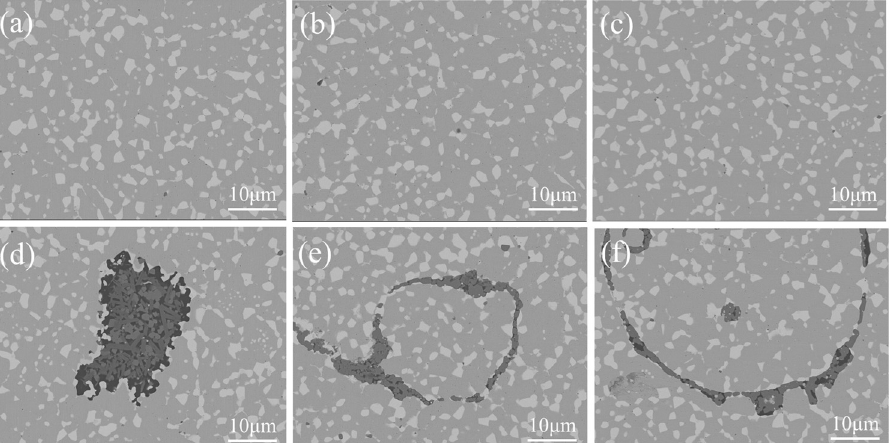
Figure 8: The SEM - BSE images of the microstructure in as - annealed alloys: ( a ) L - 50 alloy, ( b ) L - 55 alloy, ( c ) L - 60 alloy, ( d ) L - 50 alloy, ( e ) L - 55 alloy, and ( f ) L - 60